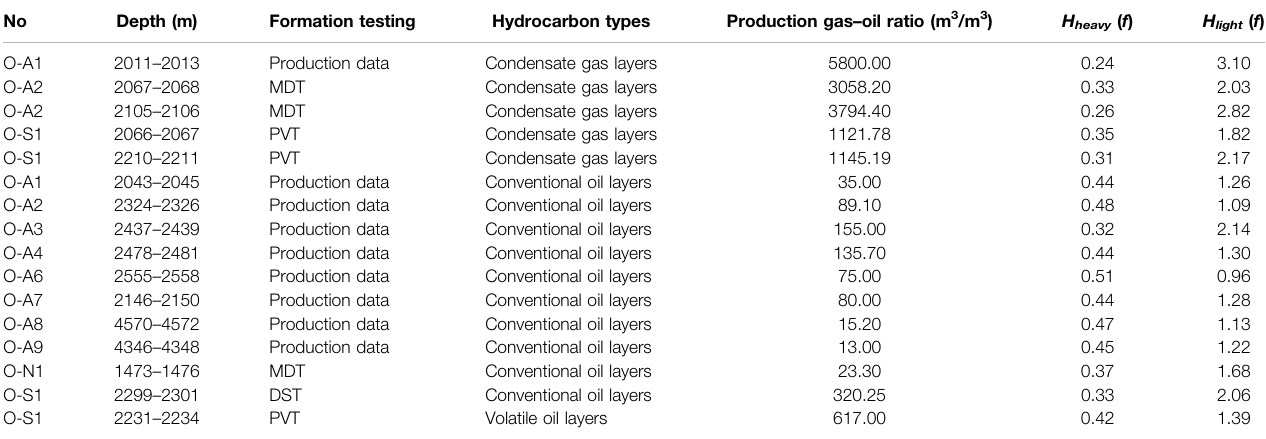
TABLE 1 | Statistical table of production gas-oil ratio and gas logging data for different hydrocarbon types in O oil fi